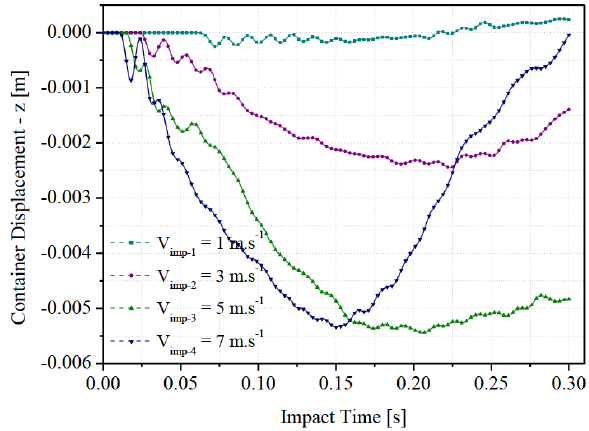
Figure 17: Displacement tendency of the container on the vertical direction